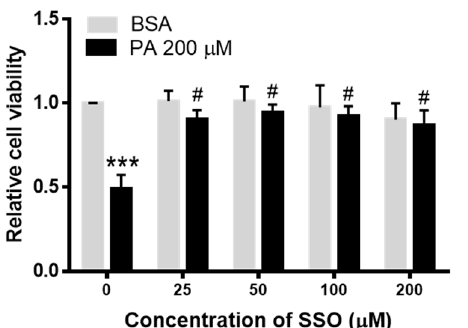
Figure 4. Cell viability analysis of N2a cells pre-treated with sulfo-N-succinimidyl oleate (SSO) for 1 h followed by treatment with BSA or PA for 24 h. N2a cells were pre-treated with different concentrations of SSO for 1 h followed by treatment with 200 µ M PA or BSA for 6 h, and cell viability was assessed by MTT assay. Data presented were representative of three independent experiments. Data (Mean ± SEM) were analyzed using two-way ANOVA followed by Tukey’s multiple comparison test. *** p < 0.001 vs. BSA control; # p < 0.05 vs. 200 µ M PA.